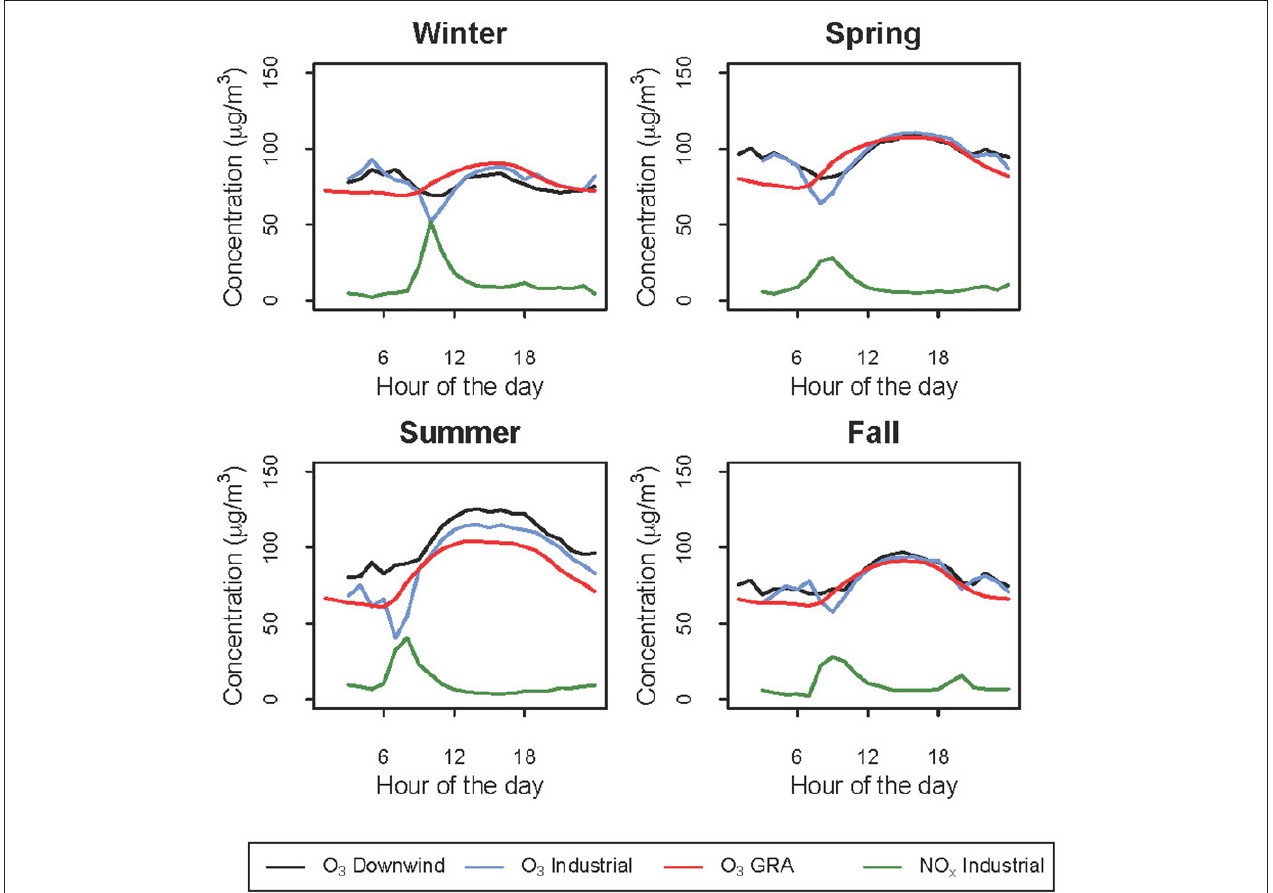
FIGURE 6 | Ozone seasonal diurnal variation under sea breeze conditions at the Priolo AERCA sites: industrial (blue lines), downwind (black lines) and at the regional background coastal site of Capo Ganitola (red lines), together with NO X diurnal trend in industrial area (green